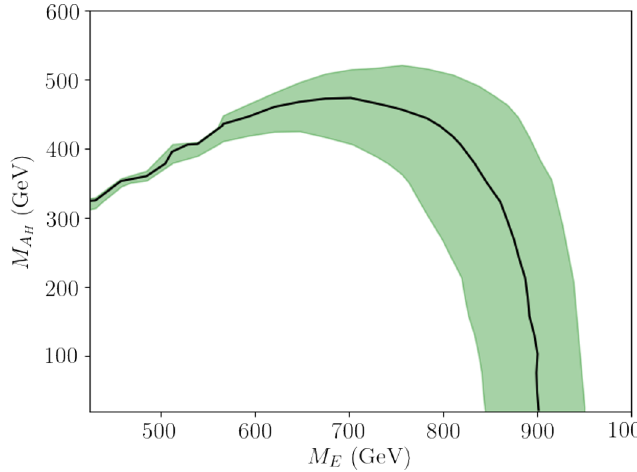
Figure 7 . Expected (solid black) and 1-sigma band (green) 95% C.L. exclusion limit in the M E − M A plane from the analysis in [21]. The excluded region is the one below the H